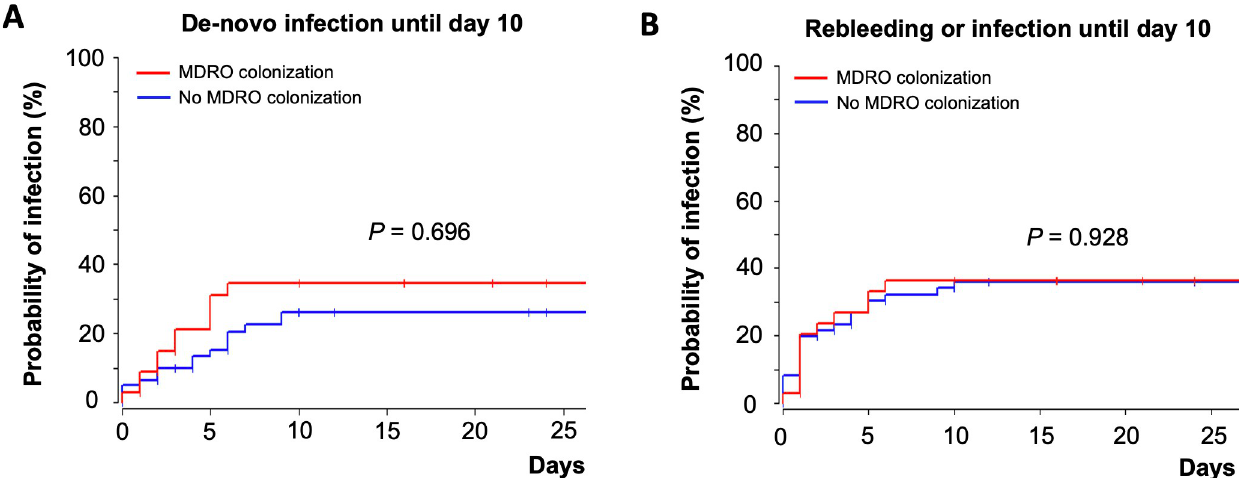
Fig 1. Kaplan-Meier curve depicting time-to event analysis in patients with and without MDRO colonization at baseline with regards to de-novo infection until day 10 (A) and the composite outcome of rebleeding or infection until day 10 (B).